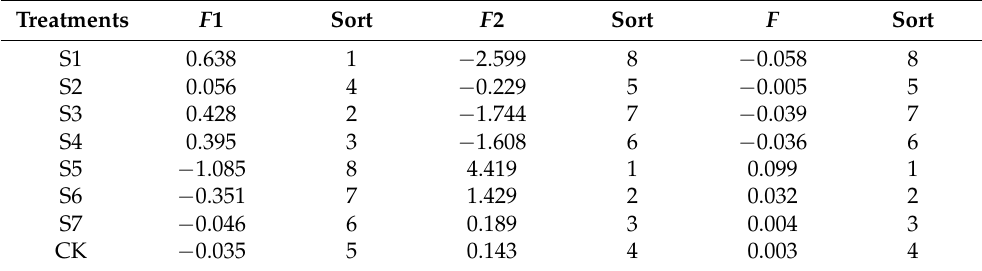
Table 7. Principal component scores of steroidal saponins in Paris polyphylla var. yunnanensis .